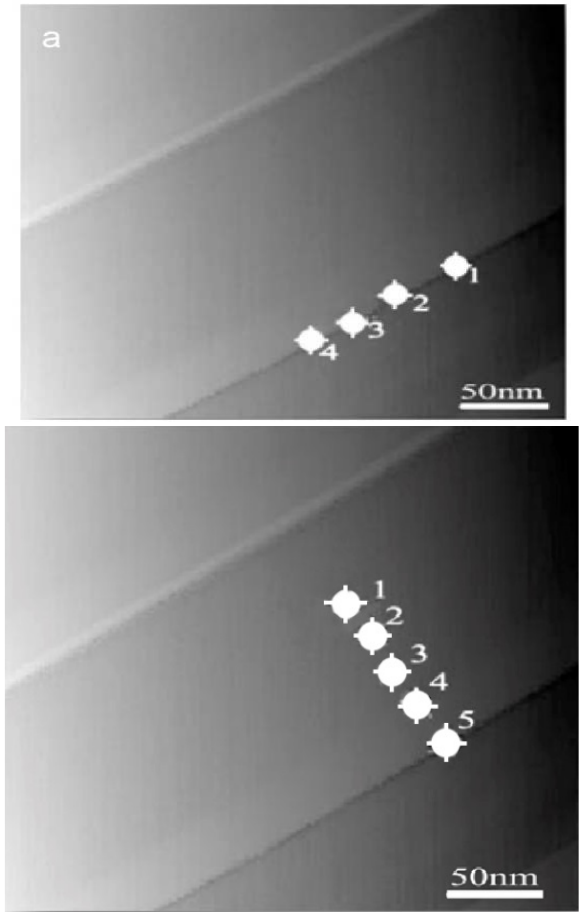
Figure 2. Points on the surface of graphite, in which the LTCVCs were measured: along the edge of the step (a) and perpendicular to the edge of the step (b) (point 5 is common).